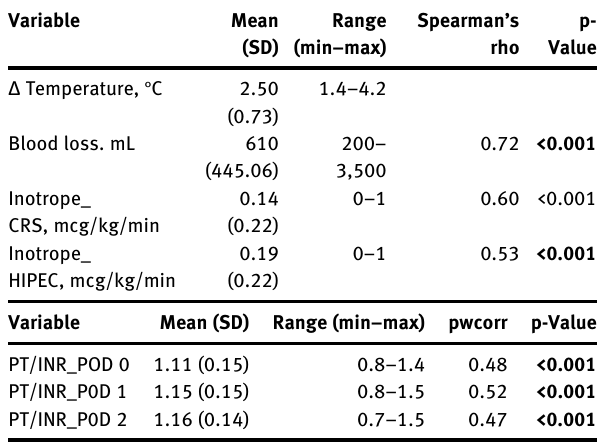
Table  : Correlation between delta ( Δ ) temperature and different perioperative